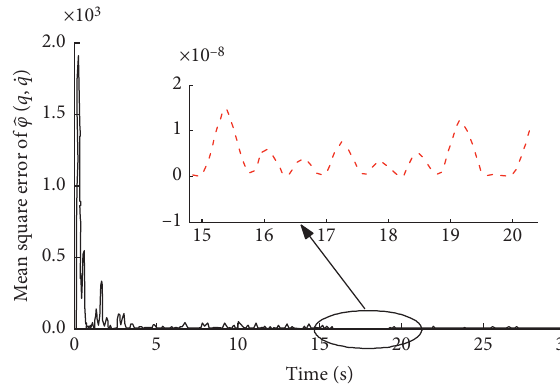
Figure 9: Mean square error of the estimation function 􏽢 φ ( q, _ q ) . –1